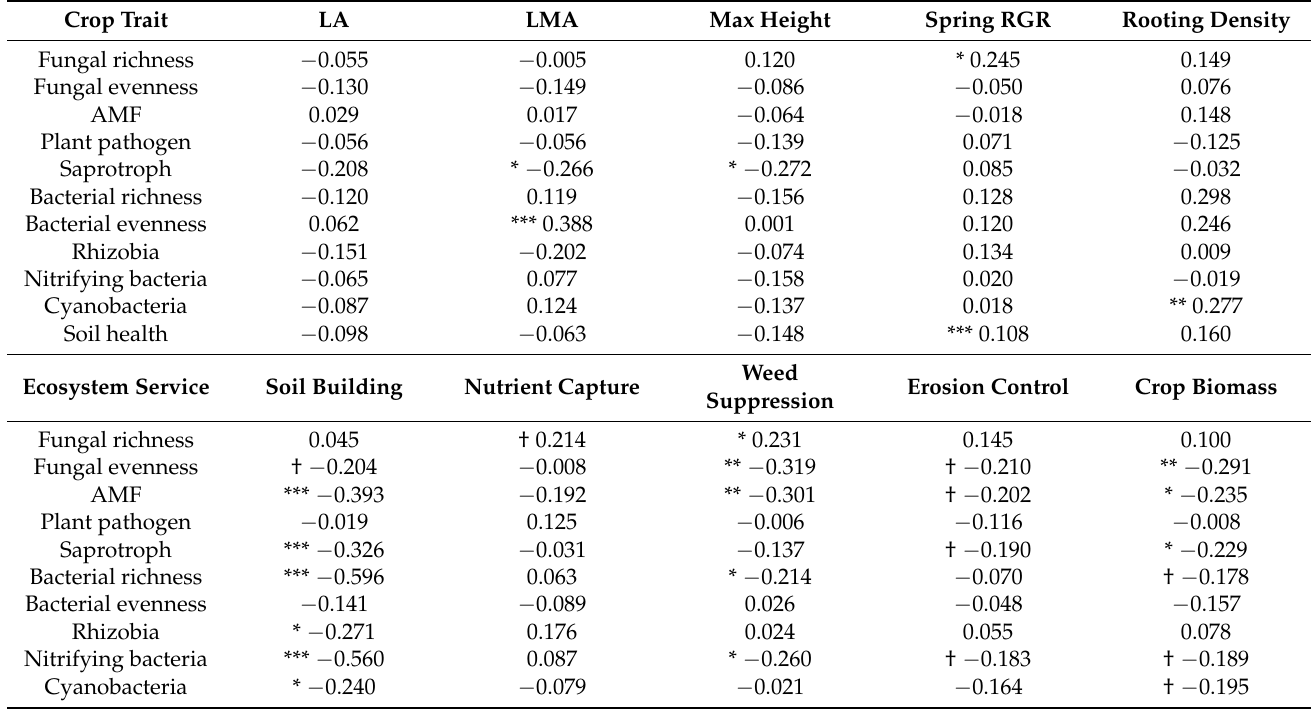
Table 3. Spearman correlation coefficients between soil microbial community characteristics with crop functional traits and ecosystem